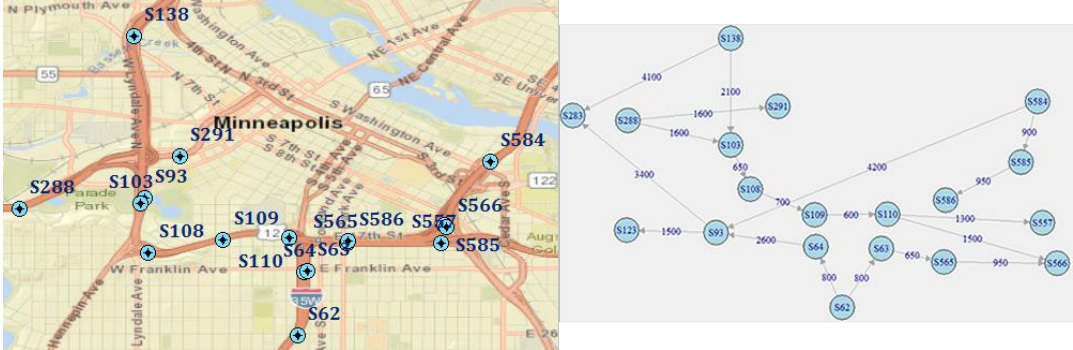
Figure 2. Road segment with non-sequential sensor locations: a map and corresponding weighted directed graph (weights represent distance by road in meters).